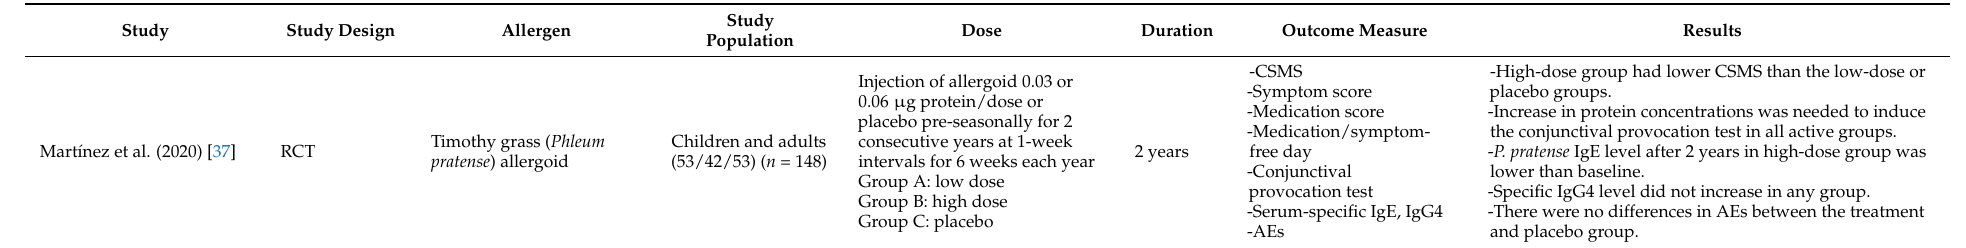
Table 2. Clinical studies of allergoids.